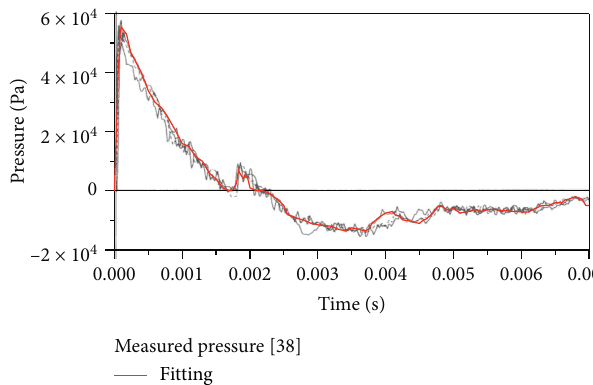
Figure 7: Reference field blast pressure time-history (adapted